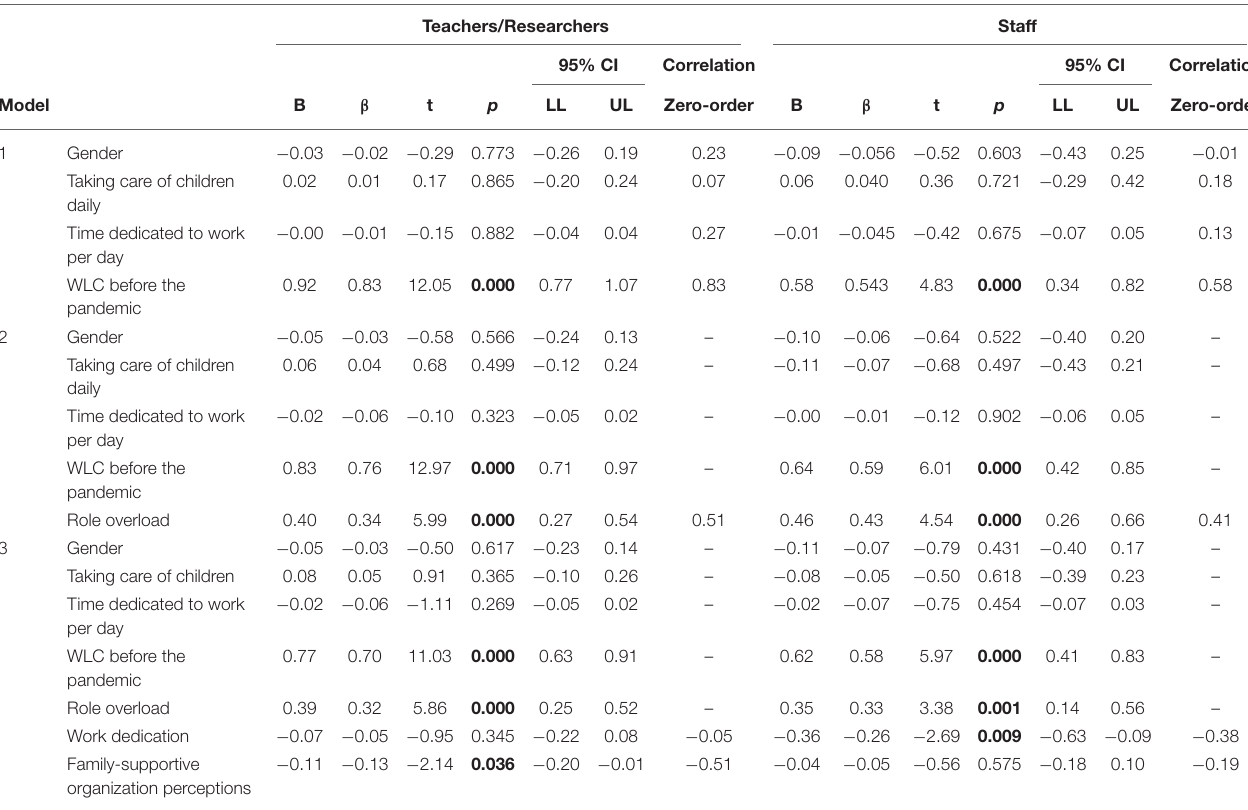
TABLE 3 | Multiple hierarchical linear regression: predictors of current WLC for teachers/researchers and staff.